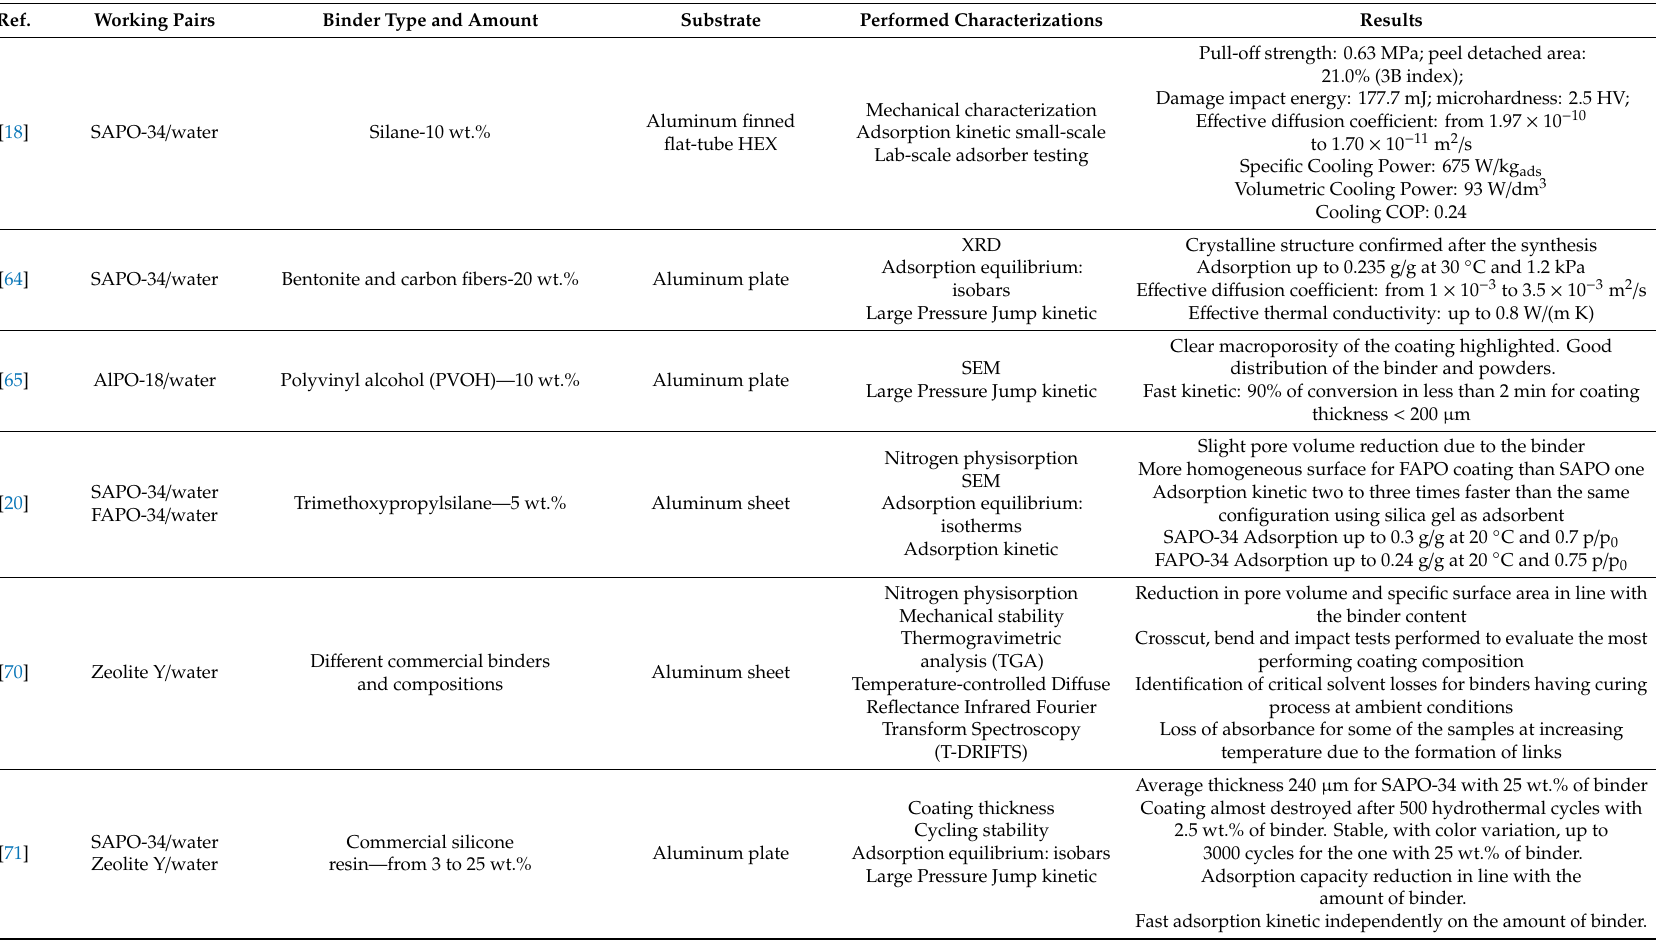
Table 3. Comparison table of the main features of composite coatings for heat pump applications.